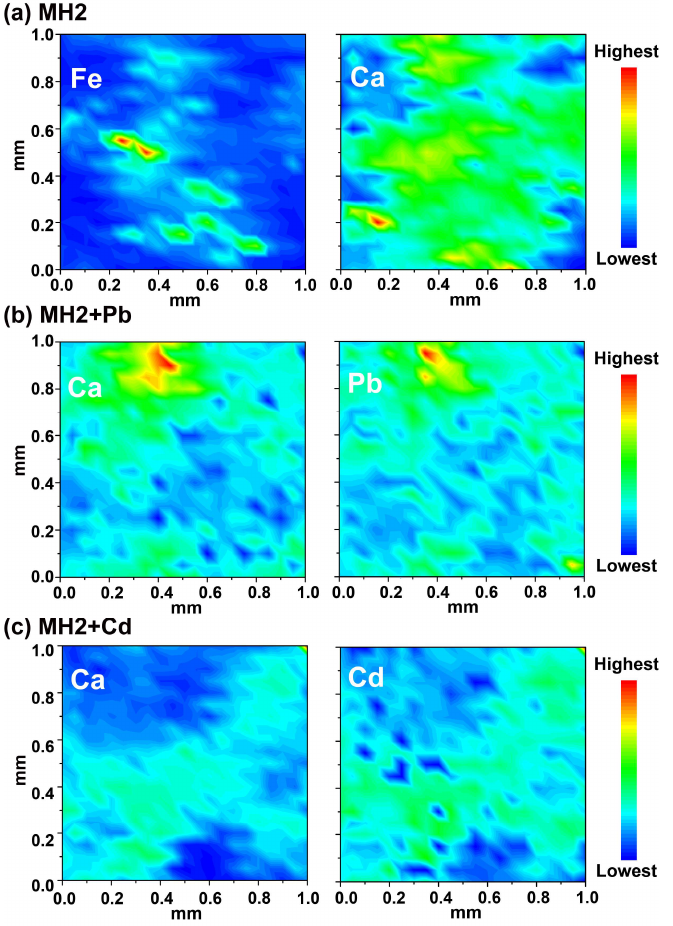
Figure 3. XRF graphs of MH2 ( a ), MH2 + Pb ( b ) and MH2 + Cd ( c ). Fe represents CMB content in MH2, C represents both CMB and LDH part in MH2.